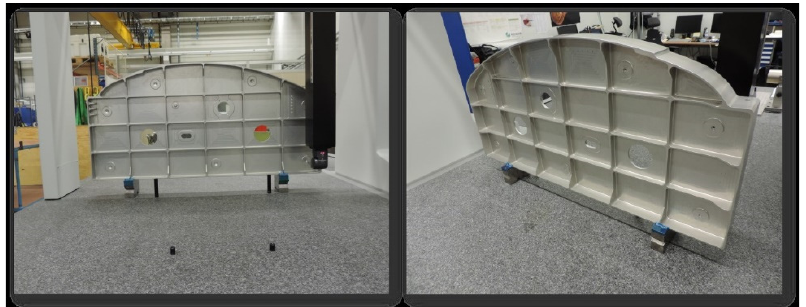
Figure 12. Verification and periodic inspection of manufactured MPQP test artefacts in a dedicated Saab calibrated and traceable reference CMM machine.